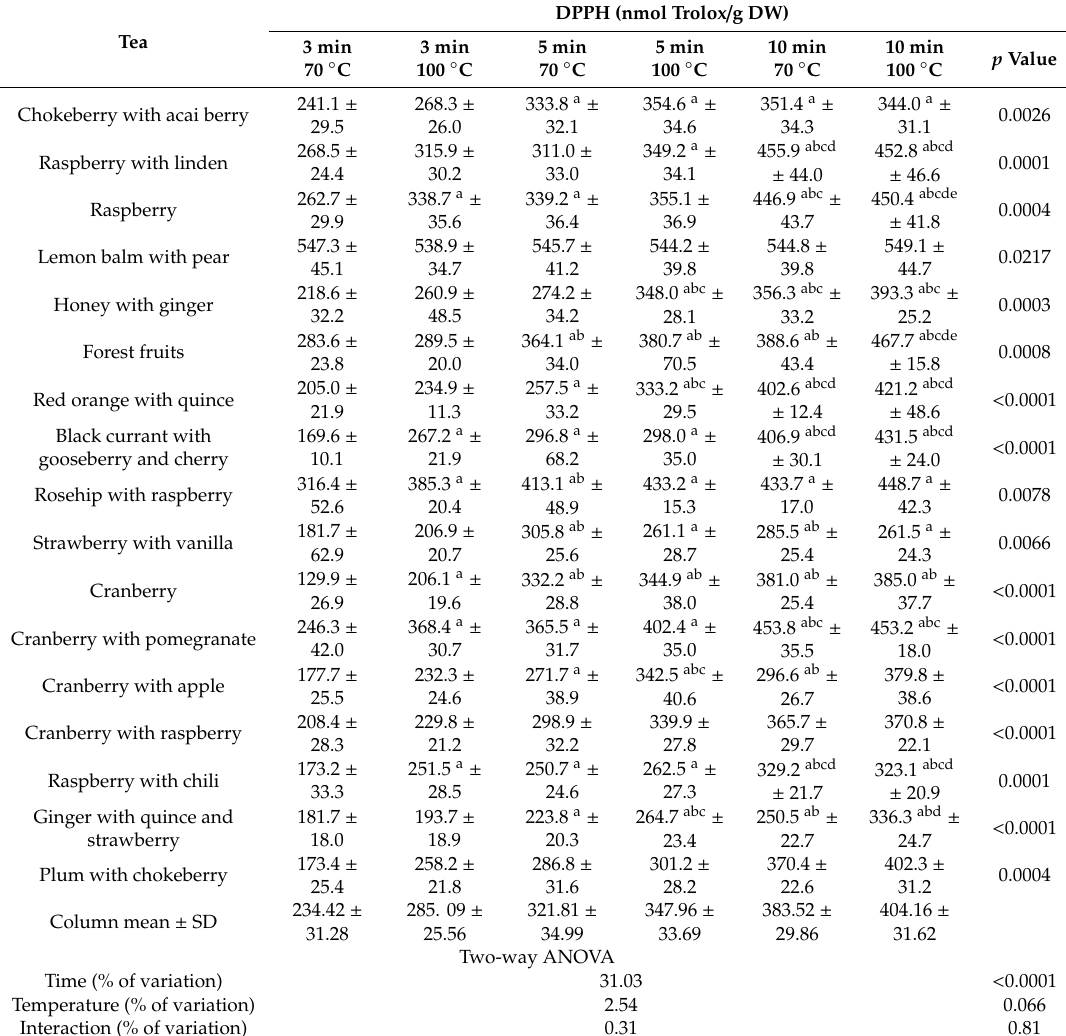
Table 3. DPPH radical ( α -diphenyl- β -picrylhydrazyl) scavenging activity in fruit tea infusions. a p